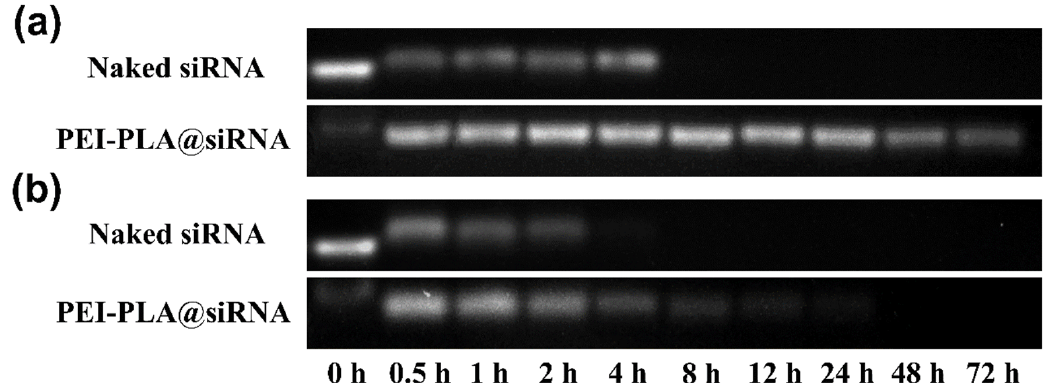
Figure 4. Agarose gel electrophoresis analysis of naked siRNA and PEI-PLA/siRNA polyplex after incubation with 10% ( a ) and 50% ( b ) serum for different time. siRNA can be dissociated from the polyplex in the presence of SDS. The naked siRNA and PEI-PLA/siRNA polyplex samples in the first lane (0 h) of ( a ) and ( b ) were prepared in the presence and absence of 1% SDS, respectively.